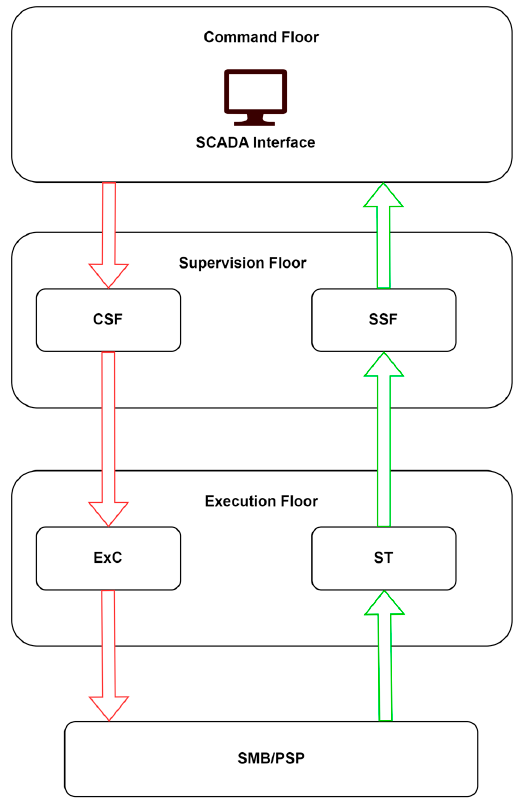
Figure 11. The functional architecture of the control system for power supply installations in a railway station. CSF—control safety fi lter; SSF—signal safety fi lter; ExC—execution of commands; ST—signaling transmission; SMP/PSP—source management block/power supply panels.